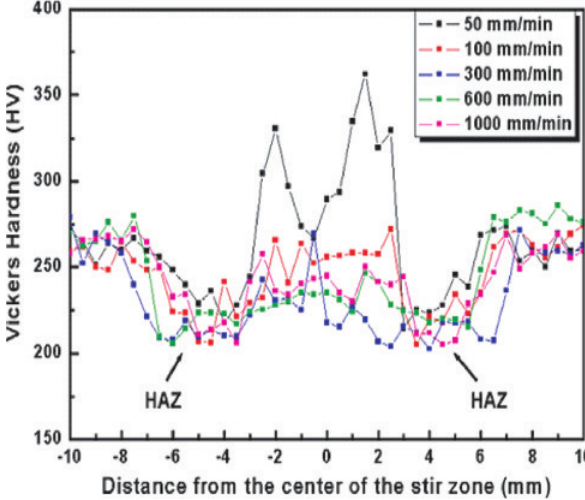
Fig. 3: Hardness distributions along the centerline of the cross- section of the stir zone